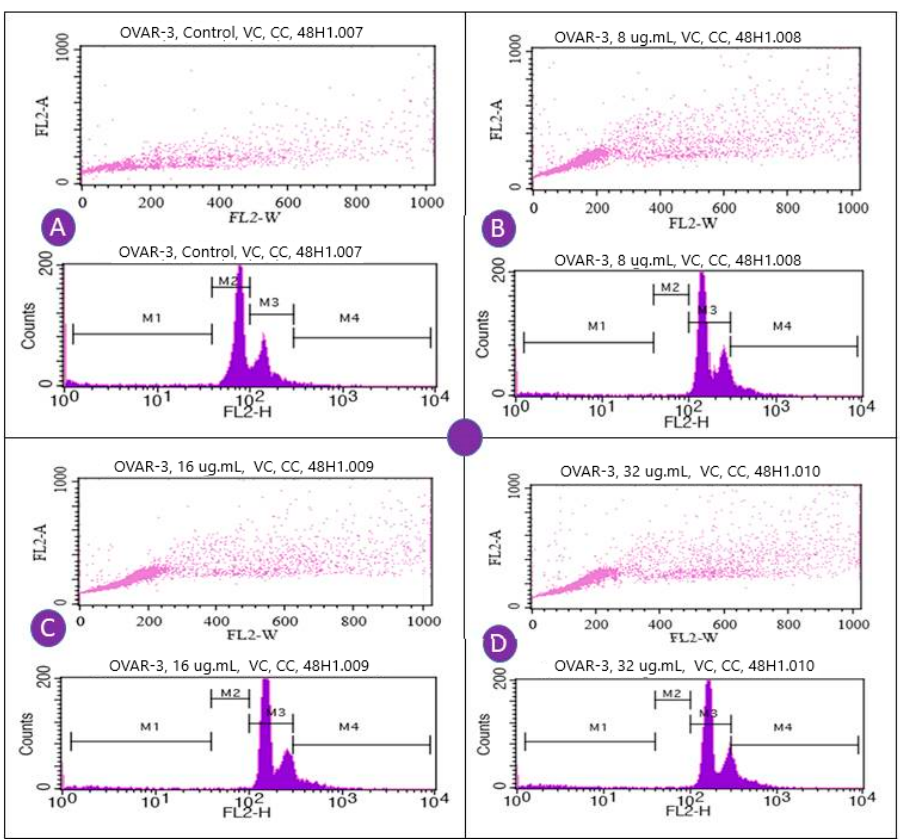
Figure 9. Representative dots plots and histogram showing cell cycle distribution of OVCAR-3 cells treated with VC-F7. The cells were fixed with methanol, stained with PI, and analyzed by flow cytometry (FACS Calibar; Becton-Dickinson) using CellQuest software as described in the Methods section. A - 0 µg/mL, B - 8 µg/mL, C - 16 µg/mL, D - 32 µg/mL. Three experiments were performed, and section. ( A ) 0 µ g / mL, ( B ) 8 µ g / mL, ( C ) 16 µ g / mL, ( D ) 32 µ g / mL. Three experiments were performed, one (1) representative experiment is shown. and one (1) representative experiment is